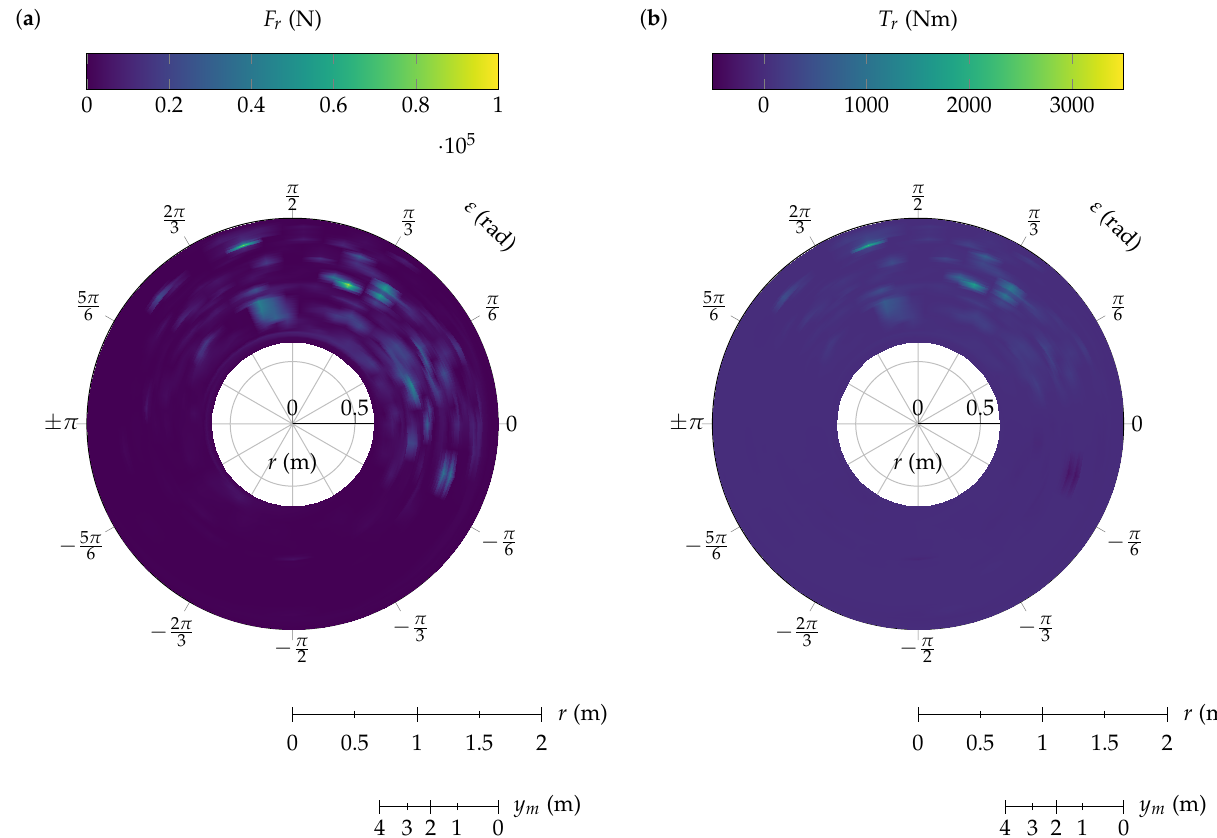
Figure 10. Polar distributions of the base case at simulation time t = 9.86 s of the base case: ( a )radial forces and ( b )torque of radial forces. ε is the transverse direction, r is the radial direction, and y m is the vertical direction. Each surface plot represents a top view of the